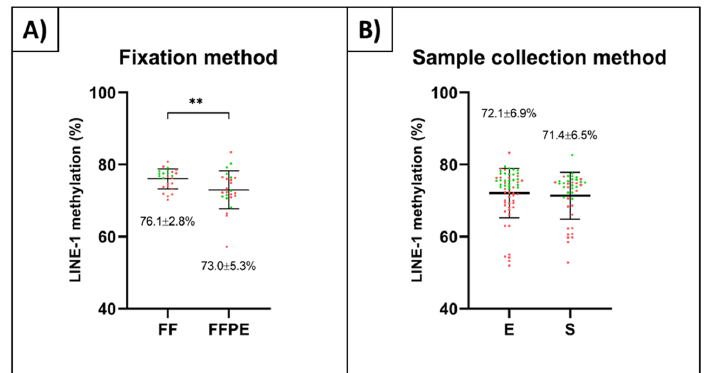
Figure 2. Influence of fixation methods and sample collection methods on LINE-1 methylation level. ( A ) FF samples (76.1 ± 2.8%) showed significantly higher LINE-1 methylation compared to FFPE specimens (73.0 ± 5.3%) (** p ≤ 0.01). ( B ) Examination of different sample collection methods